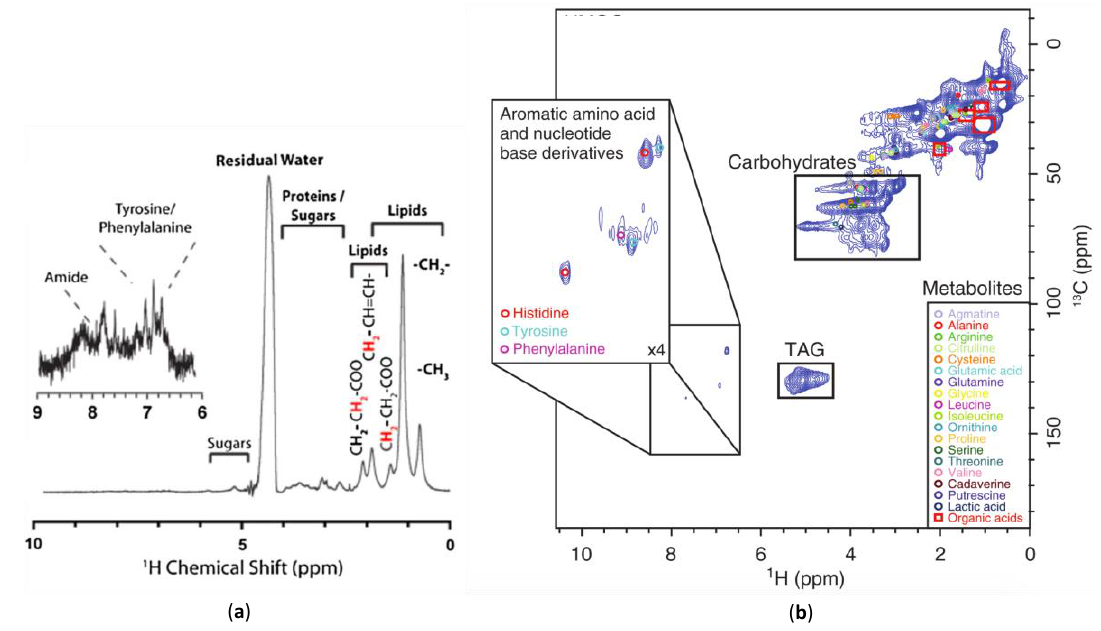
Figure 5. A comparison of: ( a ) a 1D 1 H NMR spectrum [69]; ( b ) a 2D 1 H- 13 C HMQC NMR spectrum [121] of 13 C enriched D. magna . The additional spectral dispersion afforded by 2D permits metabolite assignments not possible from the 1D data. Modified with permission from John Wiley and Sons.